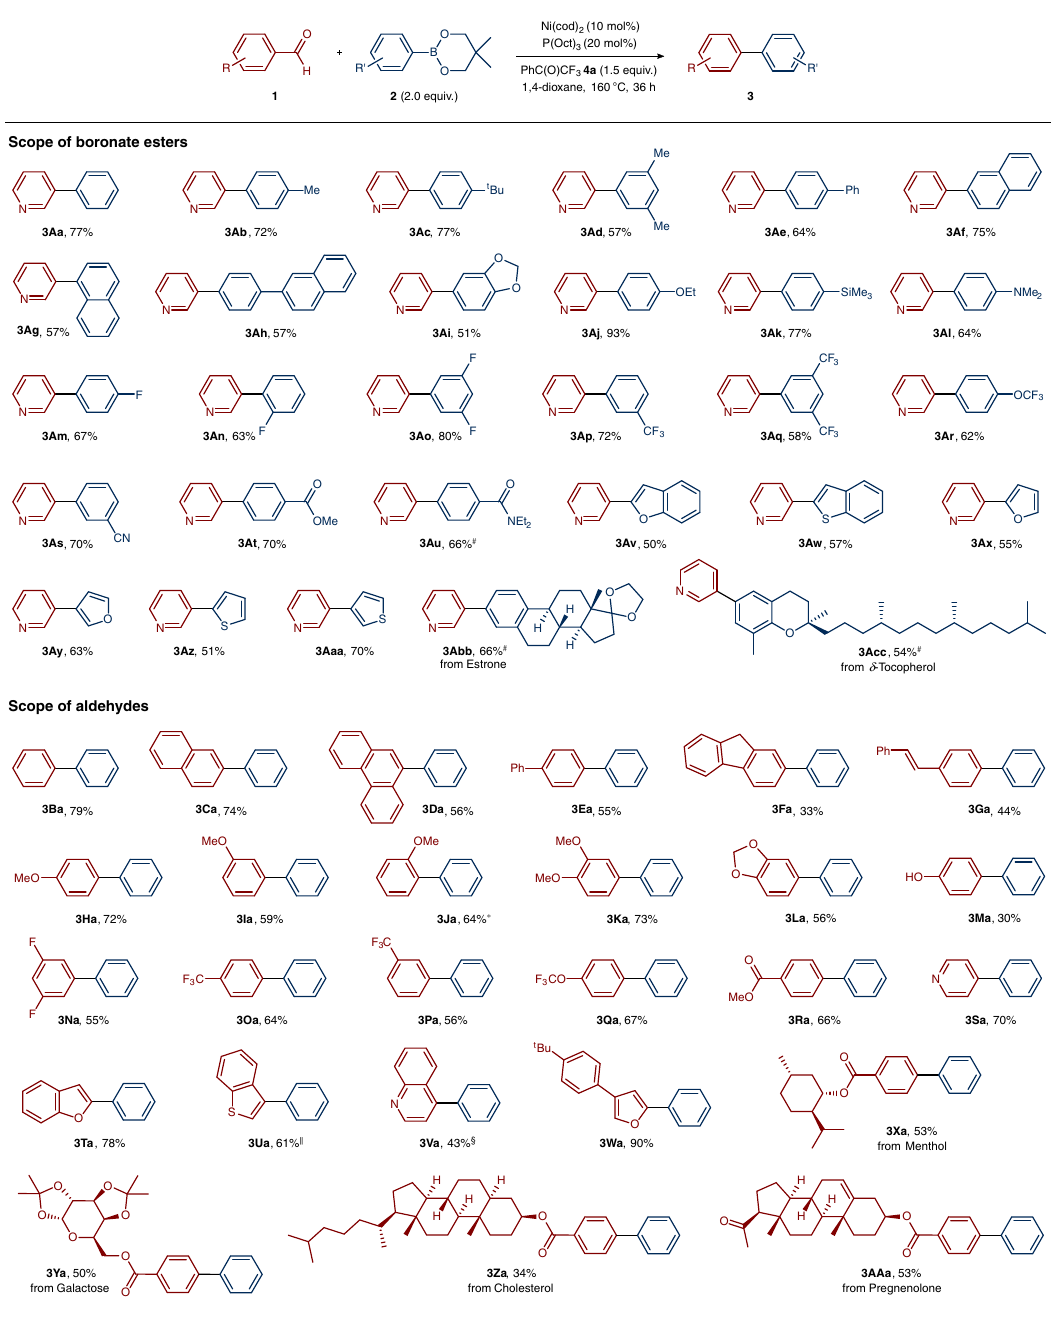
Fig. 3 Substrate scope of the Ni-catalyzed deformylative Suzuki – Miyaura cross coupling. Reaction conditions: aldehyde 1 (0.20 mmol), boronate ester 2 (0.4 mmol, 2.0 equiv.), Ni(cod) 2 (0.02 mmol, 10 mol%), P(Oct) 3 (0.04 mmol, 20 mol%), and α , α , α -tri fl uoroacetophenone ( 4a , 0.3 mmol, 1.5 equiv.) in 1,4- dioxane (1.5 ml) at 160 °C for 36 h. Yields after isolation. #1.5 equiv. of boronate ester 2 was used. *Reaction was performed with 15 mol% Ni(cod) 2 and 30 mol% P(Oct) 3 for 72 h. || Reaction was performed with 15 mol% Ni(cod) 2 and 30 mol% P(Oct) 3 for 60 h. §Reaction was performed for 60